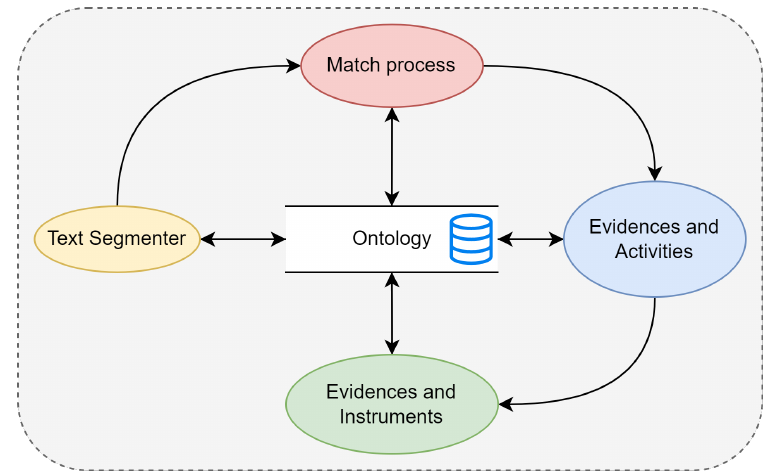
Figure 5. Text analysis component.